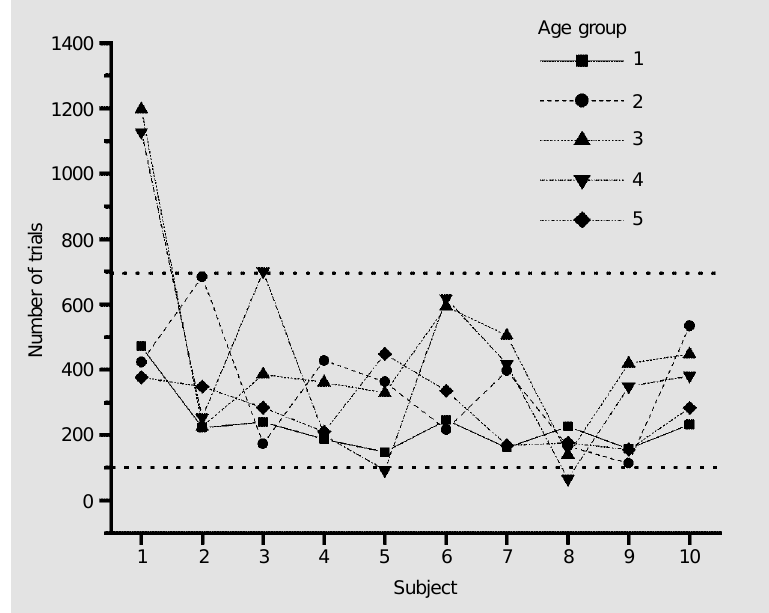
Figure 3. Calculation of number of trials to provide a mean Vernier acuity with a 10% precision. This number ranged from 66 (subject #8 of group 4) to 1068 (subject #1 of group 3). Age groups: 1 = 5-10, 2 = 11-20, 3 = 21-30, 4 = 31-40, and 5 = 41-50